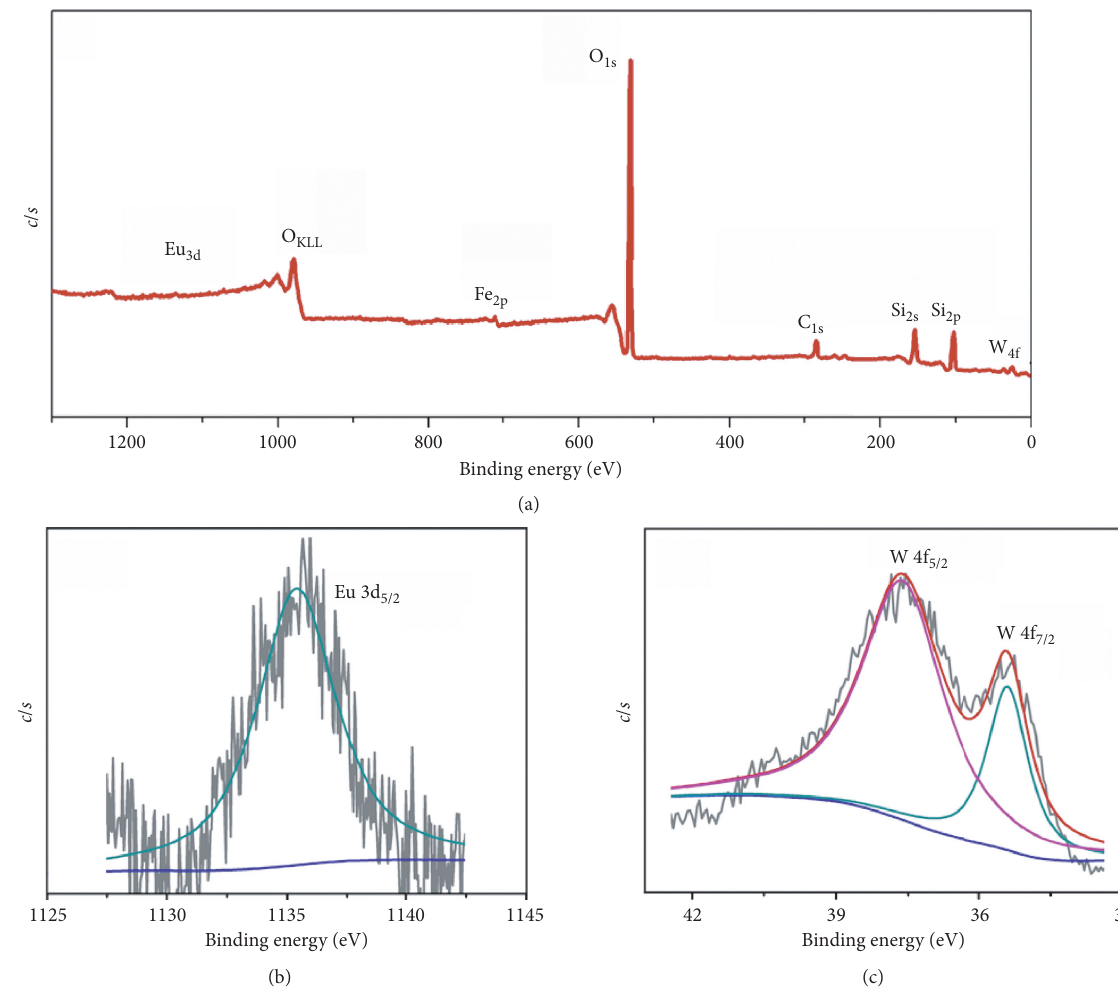
Figure 7: XPS spectra of Fe 3 O 4 @SiO 2 @LEuH@PW 10 for (a) elemental information and chemical state information for (b) Eu 3d and (c) for W 4f .